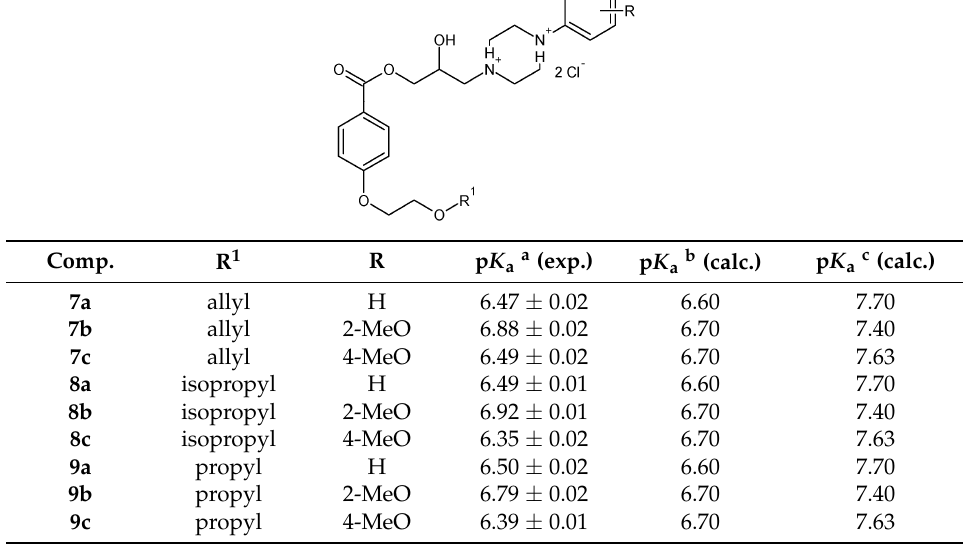
Table 2. Experimentally determined and calculated values of lipophilicity indexes (log k 7.4 w , log k w ) in comparison with software-calculated values of distribution coefficients (log D 7.4 ) and lipophilicity (log P ) of final compounds.